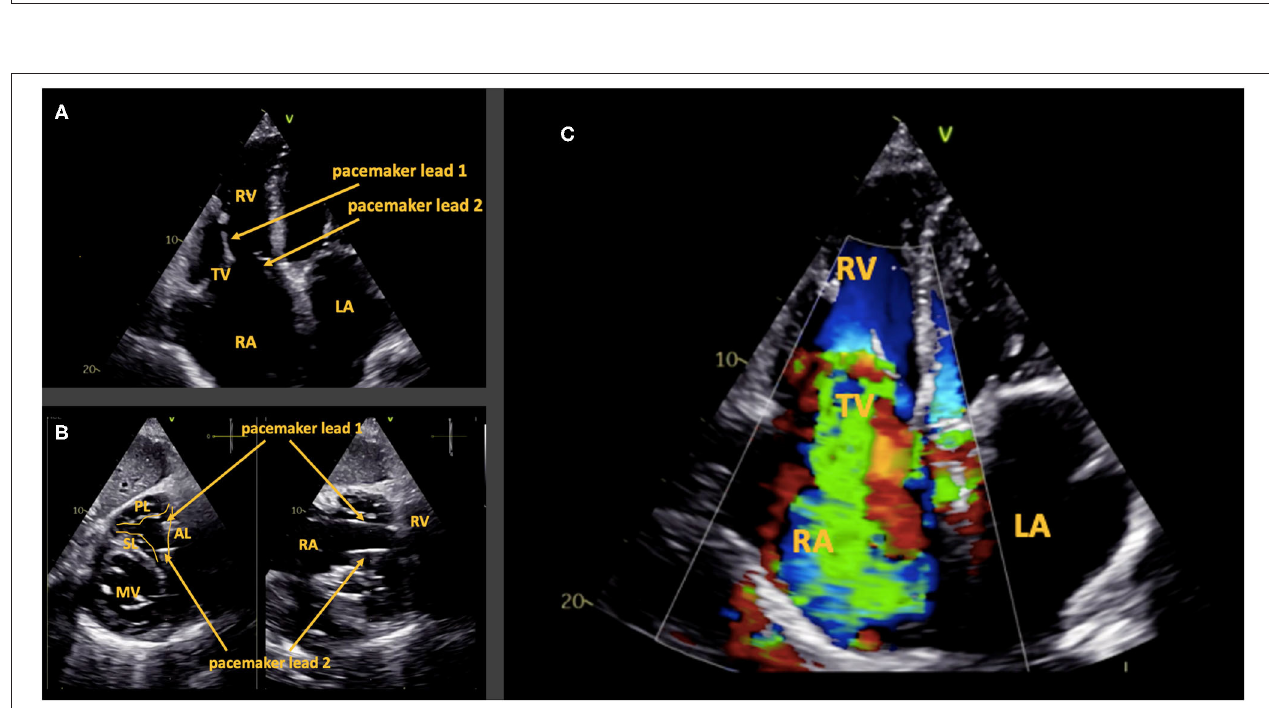
FIGURE 3 | Case 2: Leaflet perforation. Transthoracic en face view of the tricuspid valve shows the pacemaker lead passing through the posterior leaflet (A) . In transesophageal echocardiography, a deep-transesophageal commissural view of the tricuspid valve ( B , left side) with the corresponding 90 ◦ view of the septal and the posterior leaflet ( B , right side) proves perforation of the posterior leaflet. AL, anterior leaflet; PL, posterior leaflet; SL, septal leaflet; PSC, postero-septal commissure; ASC, antero-septal commissure.